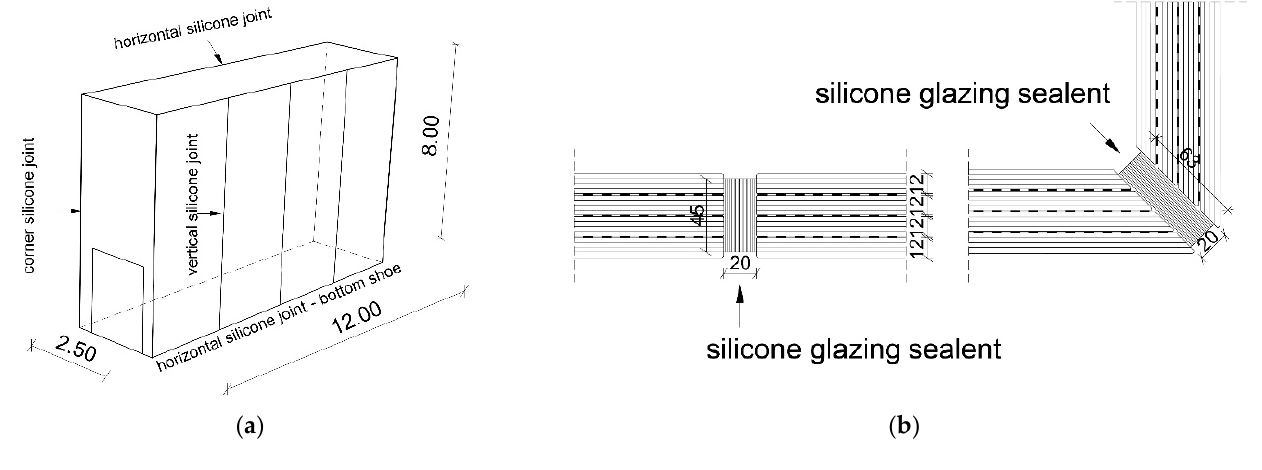
Figure 27. The Apple Retail Store in Milan: ( a ) axonometry with marked silicone joints; ( b ) detail of the connection of glass panes in the wall and the pavilion’s corner (developed by the author based on the [113]).